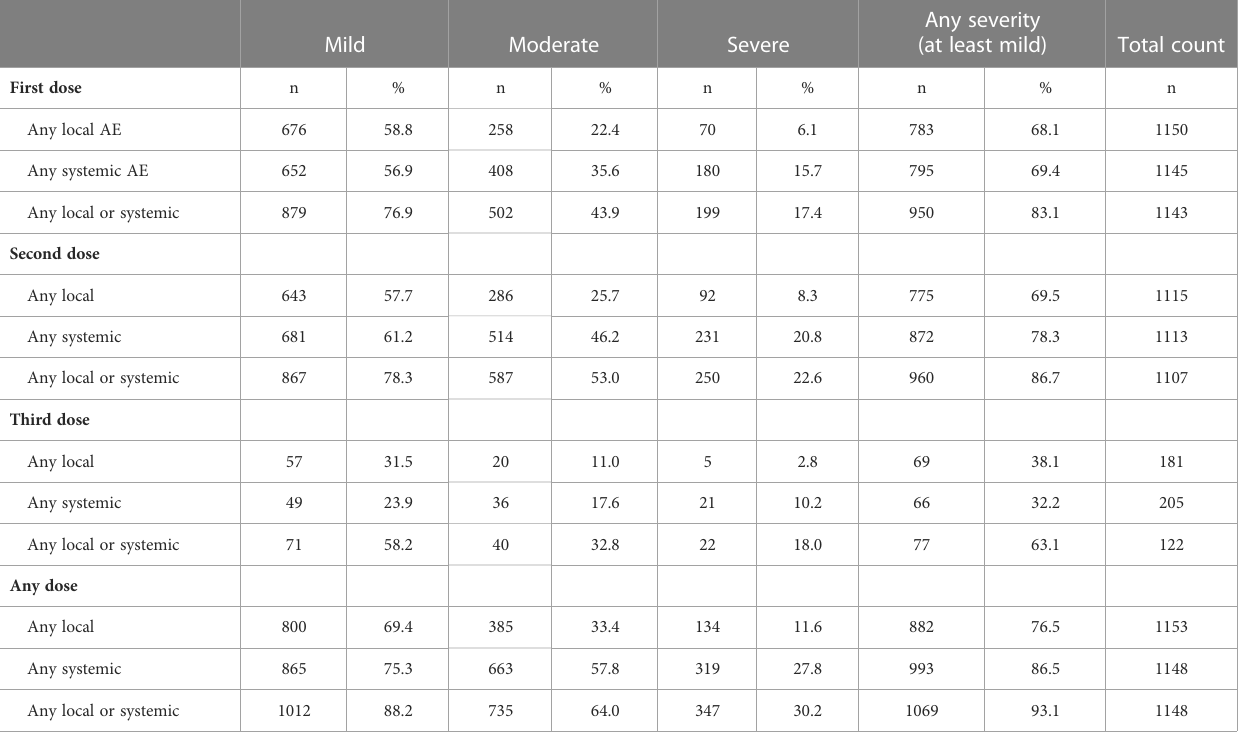
TABLE 3 Any type of local and/or systemic adverse event (AE) after fi rst, second and third dose of COVID-19 vaccine categorized according to mild, moderate, severe, or at least mild